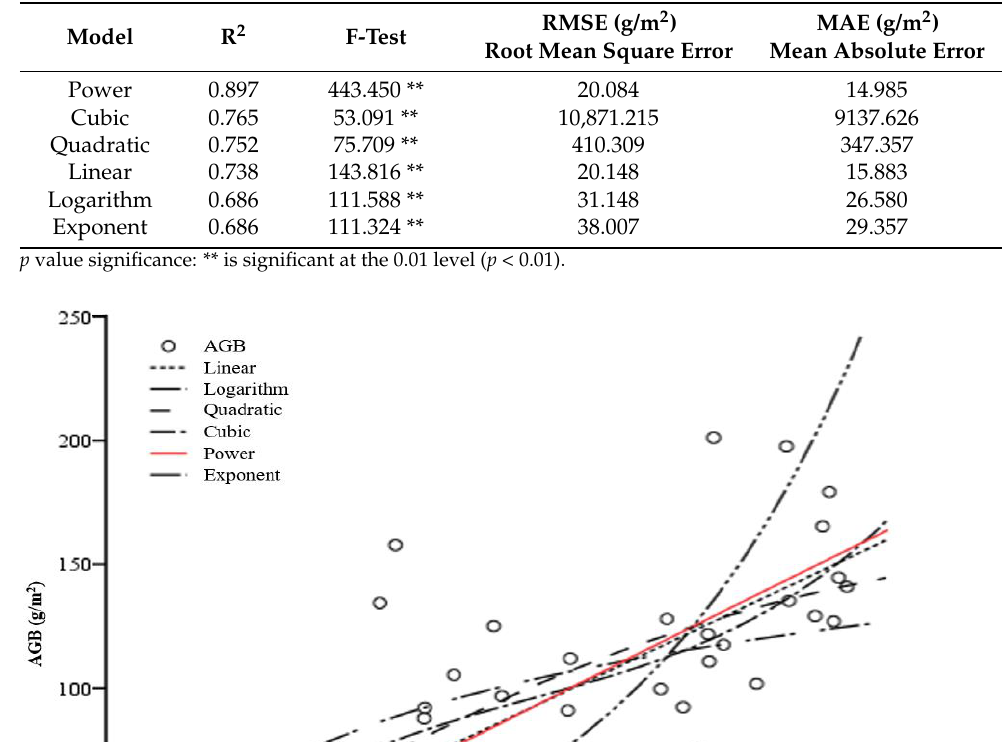
Table 4. Fitting effects of vegetation coverage and AGB.